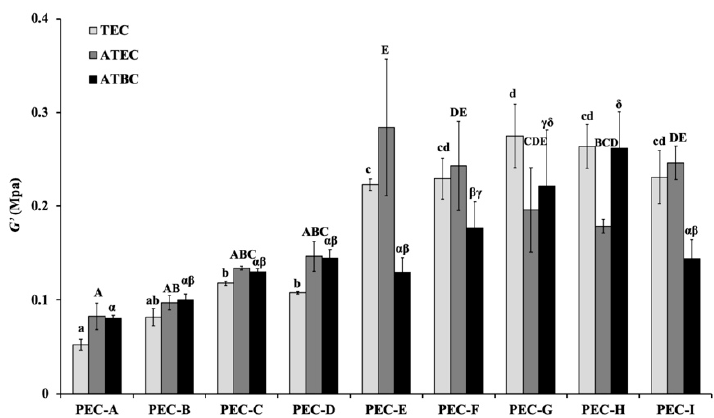
Figure 3. The storage modulus ( G ′ ) values at 1 Hz for materials before immersion. Identical letters indicate no significant differences ( p > 0.05).